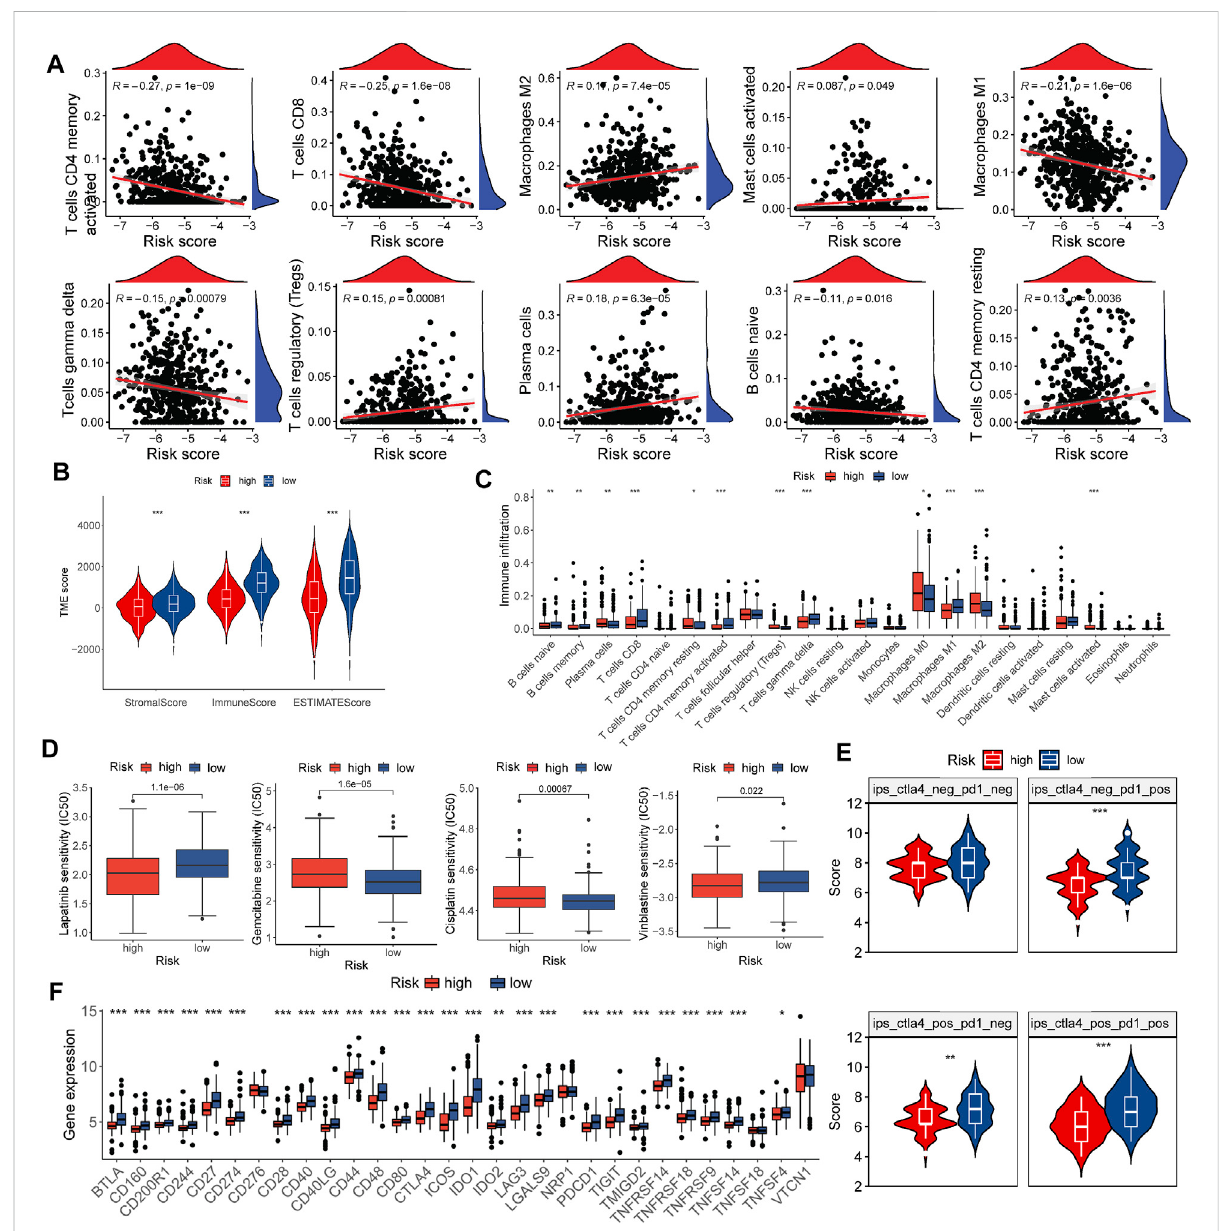
FIGURE 5 Evaluation of the TME and estimation of the role of the risk score in immunotherapy and chemotherapy ef fi cacy. (A) Correlations between the riskscoreandimmunecelltypes. (B) CorrelationsbetweentheriskscoreandtheTMEscore. (C) Abundanceof22in fi ltratingimmunecelltypesinthe two risk groups. (D) Relationship between the risk score and chemotherapeutic sensitivity. (E) Relative distribution of immunotherapy ef fi cacy in the high-risk group versus the low-risk group. (F) Expression of immune checkpoints in the high and low-risk groups. * p < 0.05, ** p < 0.01, *** p <